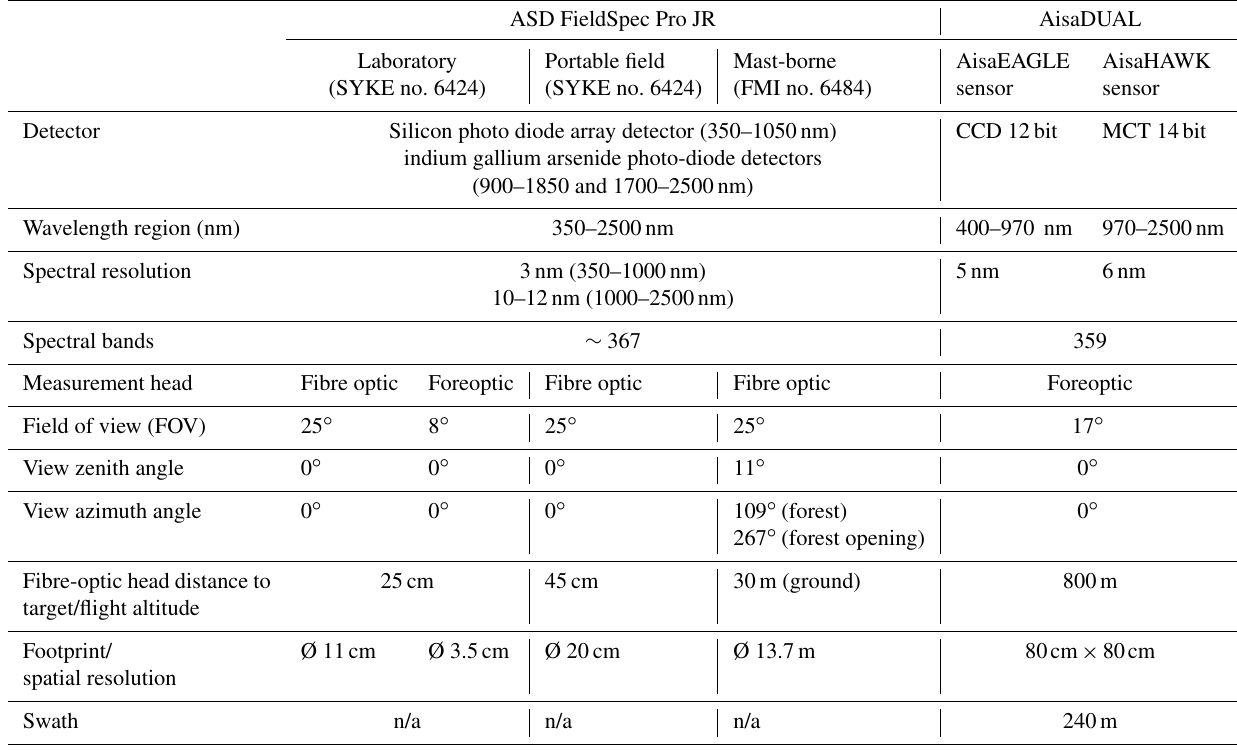
Table 1. Technical details of instruments and different installation platforms.